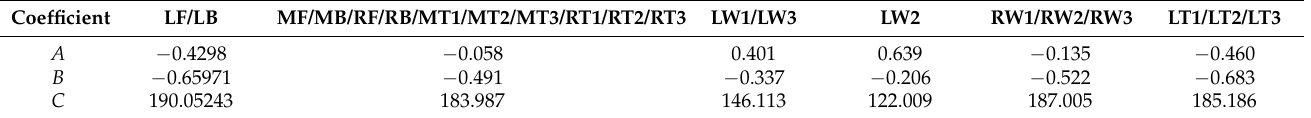
Table 9. The values of the fitting coefficients when the azimuth angle of the shed is 90 ◦